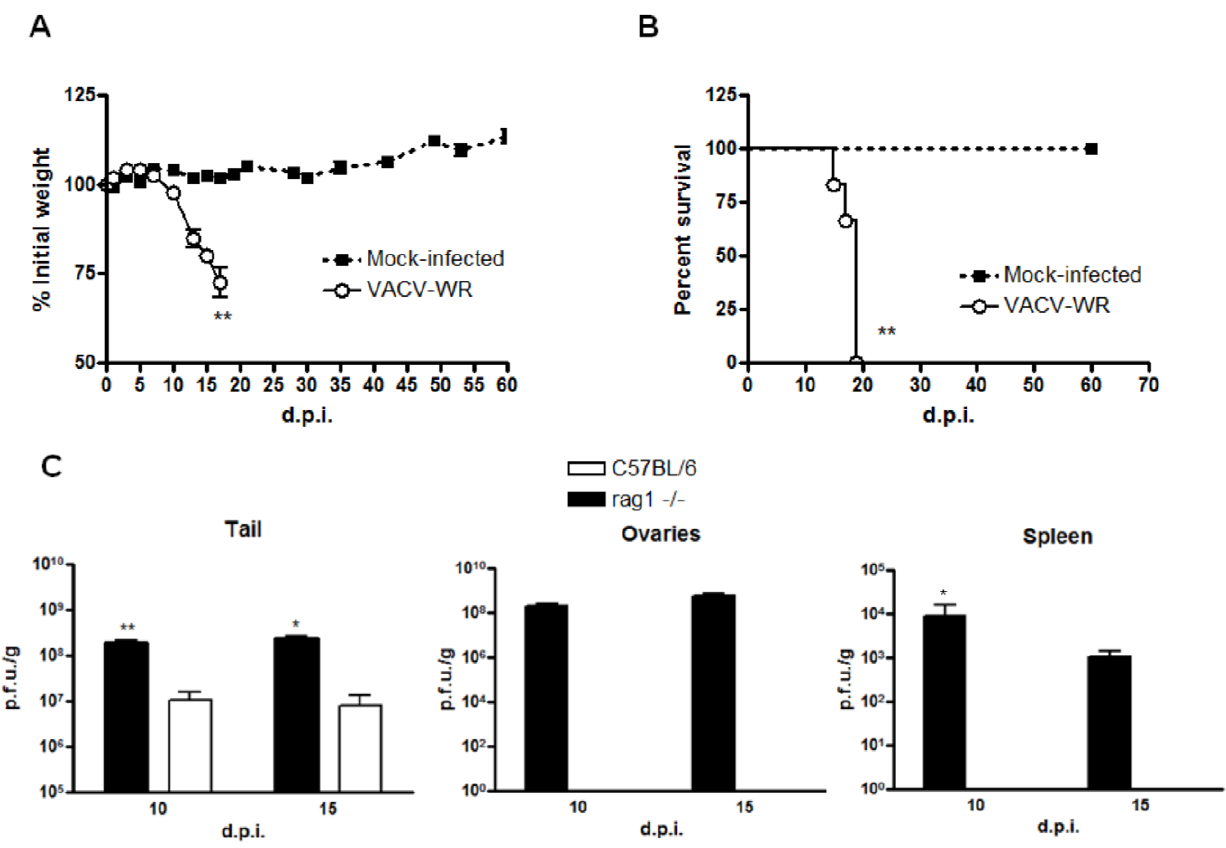
Figure 2. T and B-cell deficient mice had severe disease upon tail scarification infection with VACV-WR. Rag1 2 / 2 animals (n=6) were infected with 10 7 p.f.u. of VACV-WR by tail scarification. ( A ) Weight curve of infected or mock-infected Rag1 2 / 2 mice (** p , 0.01, unpaired t test). ( B ) Animals were followed during 60 days post-infection (p.i.) to compute mean survival (** p , 0.01, log-rank test). ( C ) WT and Rag1 2 / 2 animals were euthanized at the times indicated and the tail, spleen and ovaries were removed and titrated in BSC-40 cells. Bars represent the mean and standard error (SEM). The results are representative of three experiments.